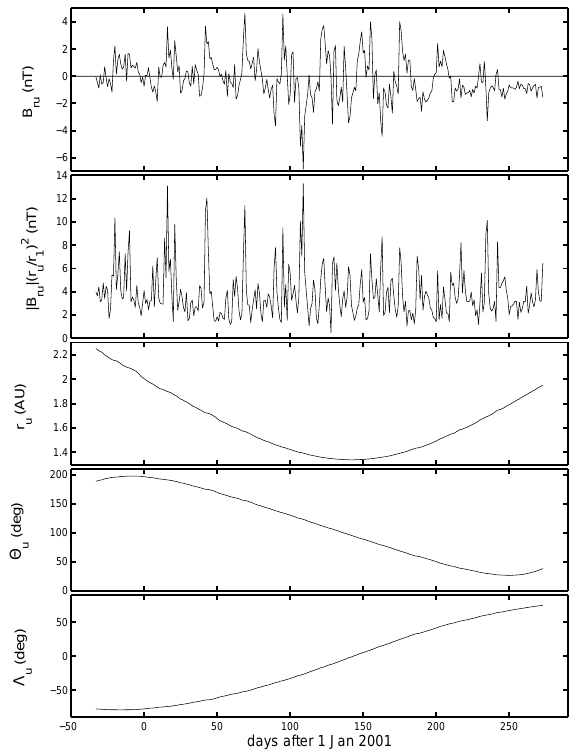
Fig. 9. Same as Fig. 5 for the second perihelion